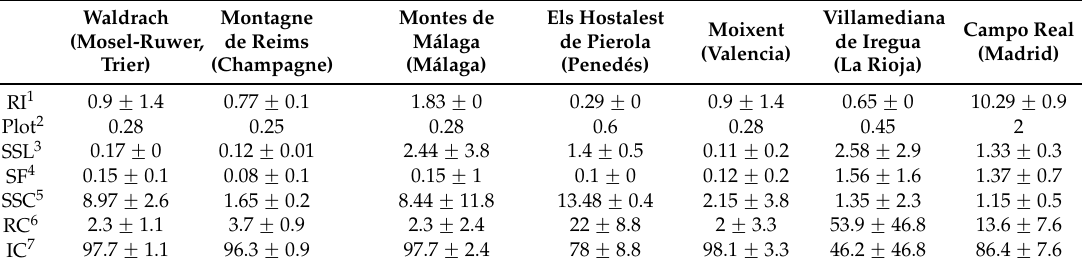
Table 3. Rainfall simulation results during the first 15